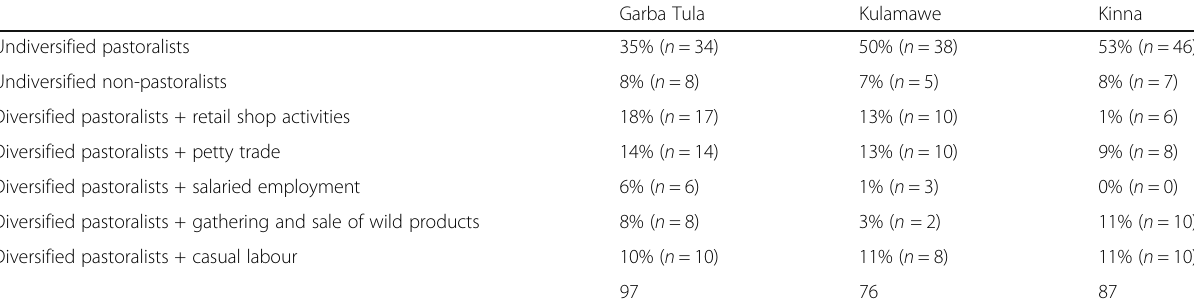
Table 3 Percentage households by livelihood strategy